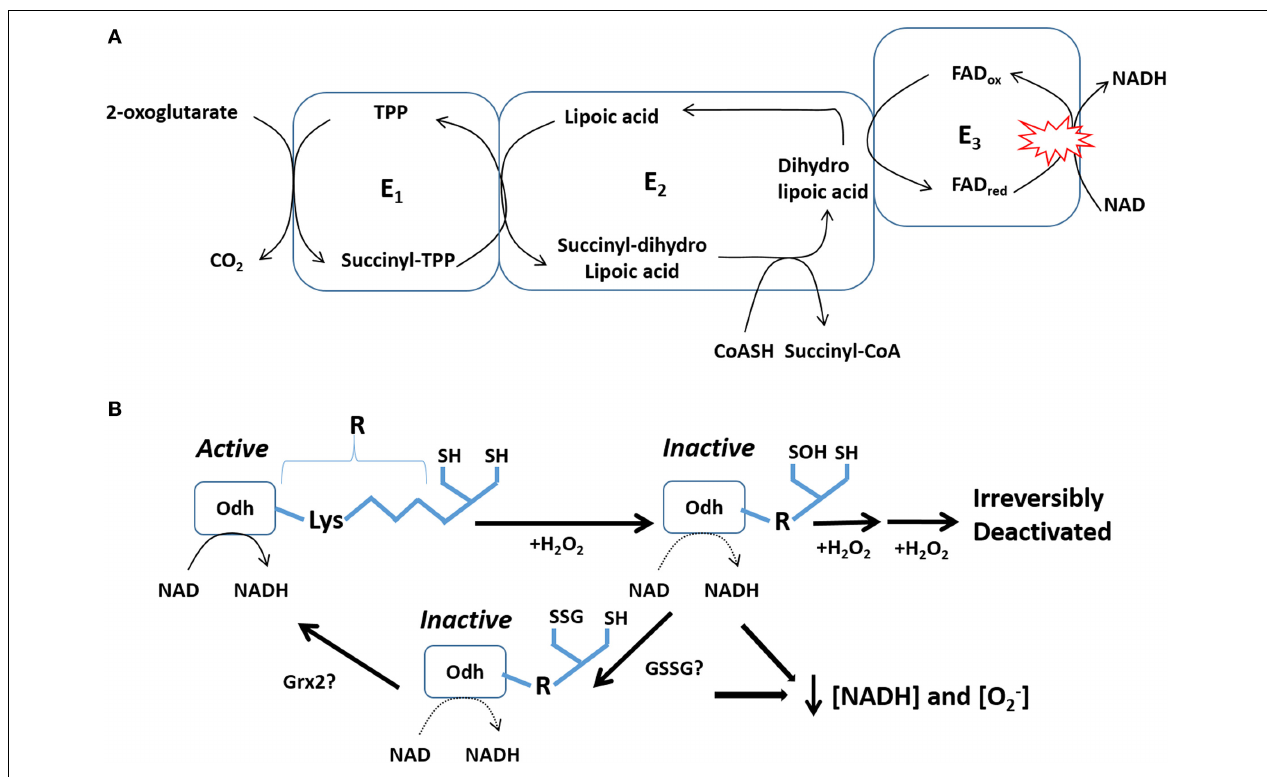
FIGURE 2 | Odh serves as an important sensor for mitochondrial O 2 (cid:129) − /H 2 O 2 levels. (A) Odh-mediated conversion of 2-oxoglutarate into succinyl-CoA depends on electron transfer reaction to NAD generating NADH. Movement of electrons from 2-oxoglutarate is facilitated by lipoic acid and FAD in the E 2 and E 3 subunits. Red circles : represent the major site